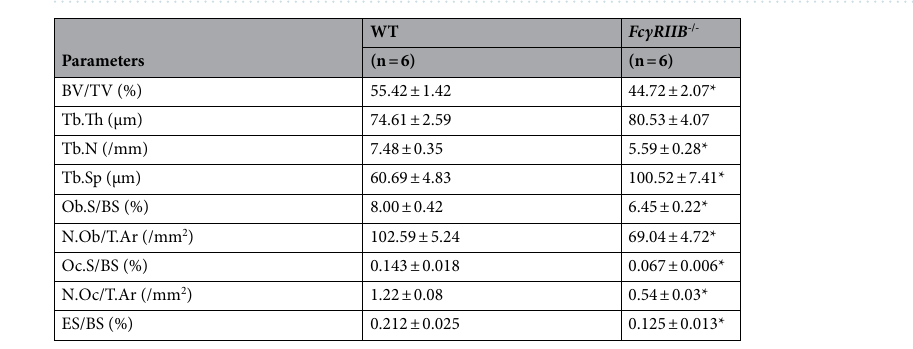
Table 1. Histomorphometric analysis of mandibles from 6-month-old FcγRIIB -/- mice and their WT controls. Results are mean ± SEM. * p < 0.05 compared to WT, unpaired t -test.